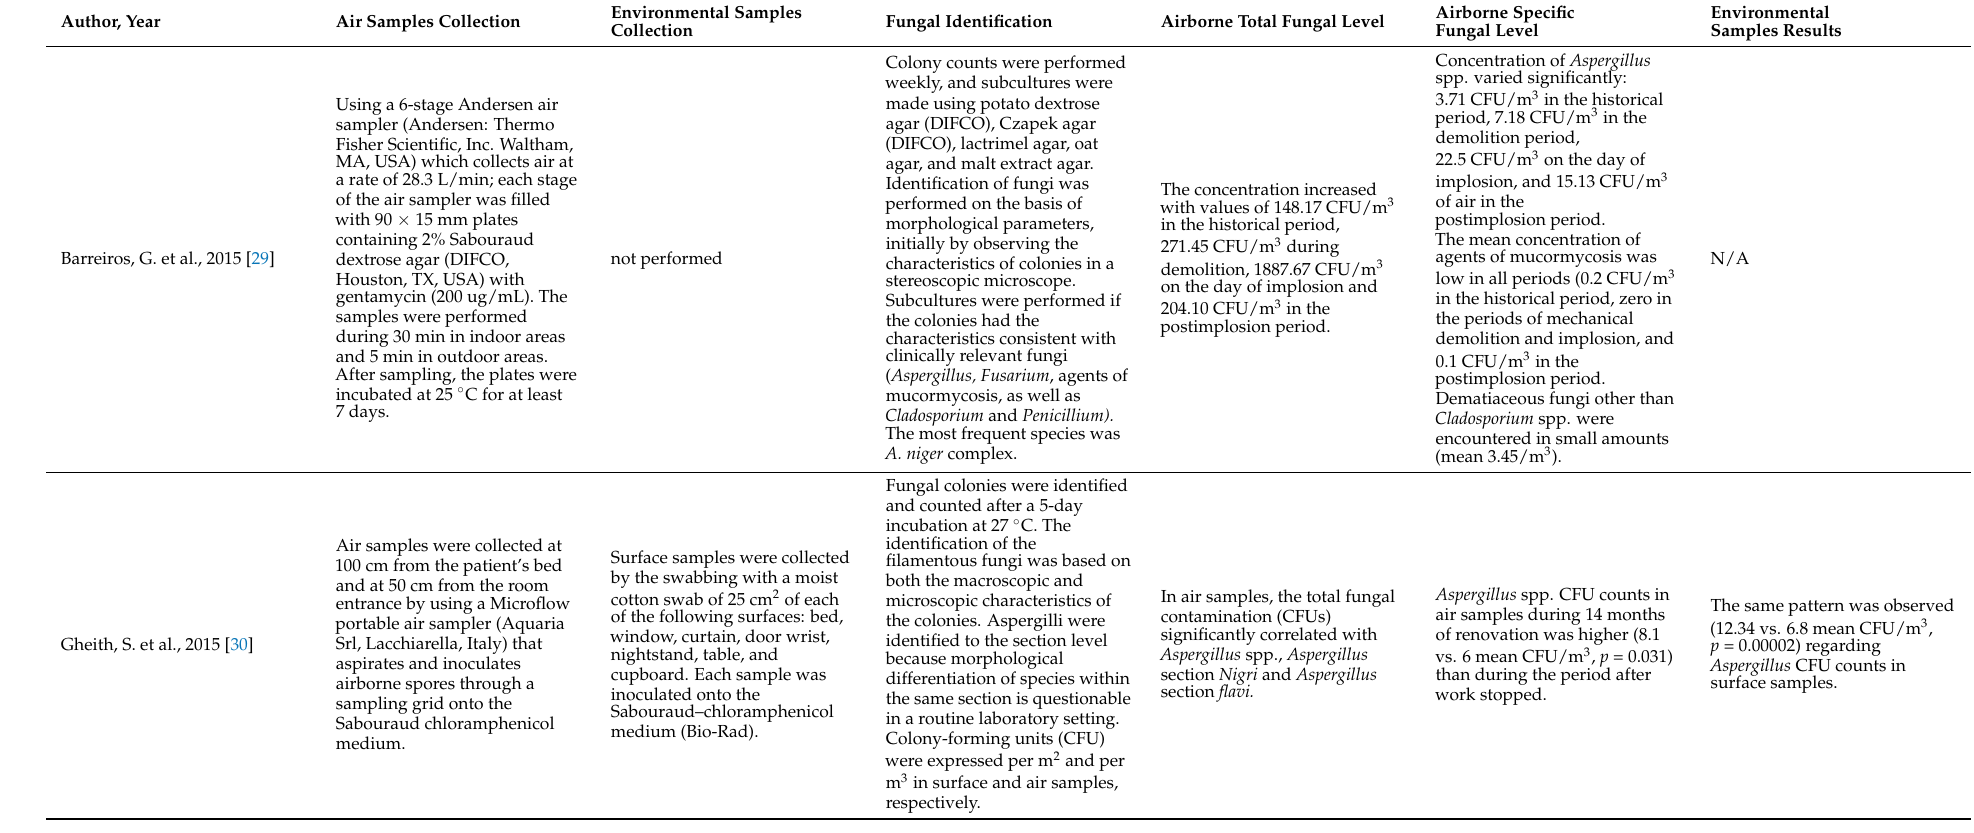
Table 2. Methods used for collecting air and environmental samples, fungal identification, and measured total and specific airborne fungal levels during fungal outbreaks and infections associated with construction or renovation described in articles published from January 2015 to December